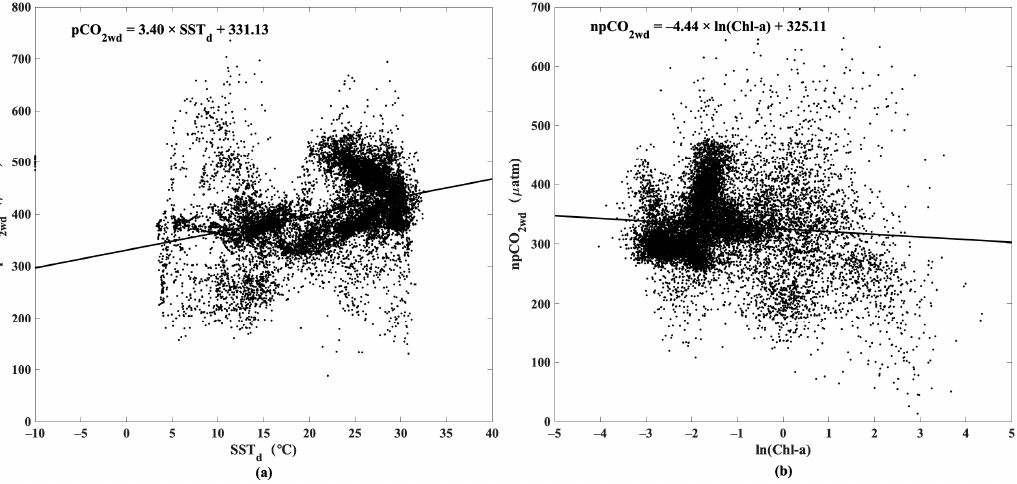
pCO and SST d , and 2wd n pCO ) and Chl-a . 2wd